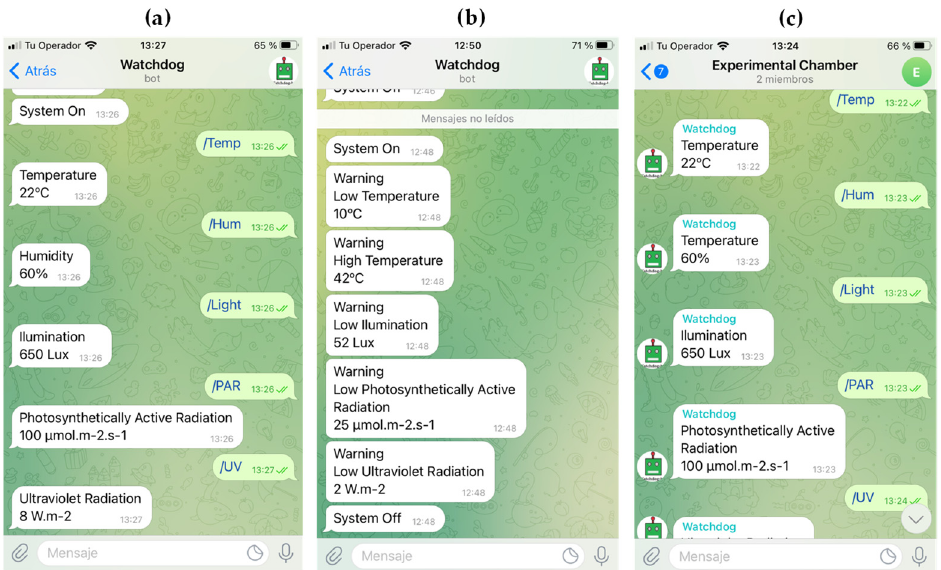
Figure 5. ( a ) Chat between the user and the bot. ( b ) The bot warns of out-of-range values. ( c ) Chat group in which there are several members with the bot.